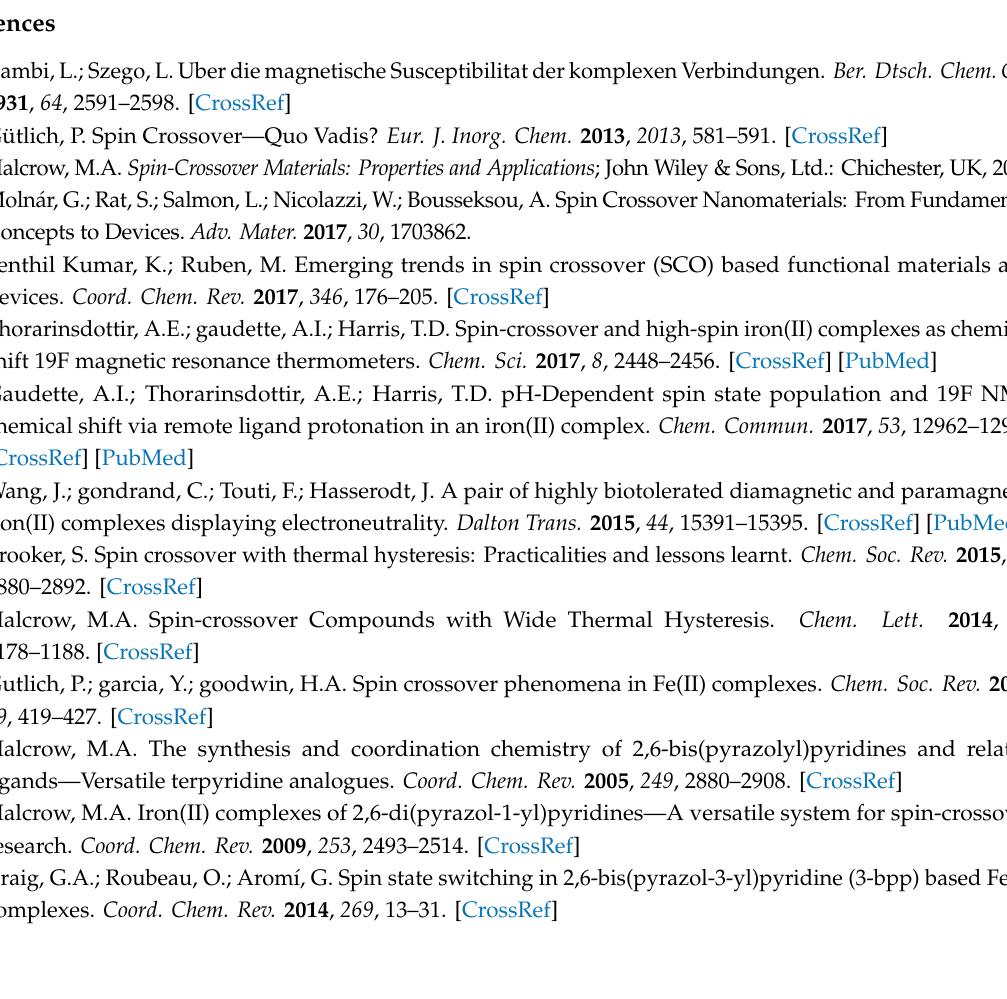
Figure S1: general view of the cation [Fe( L ) 2 ] 2 + in [Fe( L ) 2 ](BF 4 ) 2 · 2CH 3 CN (red) from X-ray di ff raction at 120, Figure S2: general view of the cation [Fe( L ) 2 ] 2 + in [Fe( L ) 2 ](BF 4 ) 2 · 2CH 3 CN (yellow) from X-ray di ff raction at 120 K and 293 K, Figure S3: A fragment of the crystal packing in [Fe( L ) 2 ](BF 4 ) 2 · 2CH 3 CN (red), Figure S4: ‘Terpyridine-embrace’-like and spiral-like packing of the cations [Fe( L ) 2 ] 2 + in [Fe( L ) 2 ](BF 4 ) 2 · 2CH 3 CN (yellow), Figure S5: Hirshfeld surface of the cation [Fe( L ) 2 ] 2 + in [Fe( L ) 2 ](BF 4 ) 2 · 0.5H 2 O (red) and a 2D fingerprint plot as generated by Crystal Explorer, Figure S6: Hirshfeld surface of the cation [Fe( L ) 2 ] 2 + and its 2D fingerprint plot for [Fe( L ) 2 ](BF 4 ) 2 · 2CH 3 CN (yellow) at 293 K, Figure S7: Unit cell parameters a , b , and c of [Fe( L ) 2 ](BF 4 ) 2 · 2CH 3 CN (yellow) at 120 and 293 K, Figure S8: Shortest distances between the iron(II) ions in and between the infinite spirals of the cations [Fe( L ) 2 ] 2 + in [Fe( L ) 2 ](BF 4 ) 2 · 2CH 3 CN (yellow) at 120 and 293 K, Figure S9: Variable-temperature 1 H NMR spectra for [Fe( L ) 2 ](BF 4 ) 2 in acetonitrile-d 3 and in dichloromethane-d 2 , Table S1: Main geometric parameters and continuous symmetry measures as obtained from TPSSh / def2-TZVP calculations of [Fe( L ) 2 ] 2 + in the LS and the HS state with acetonitrile and water as